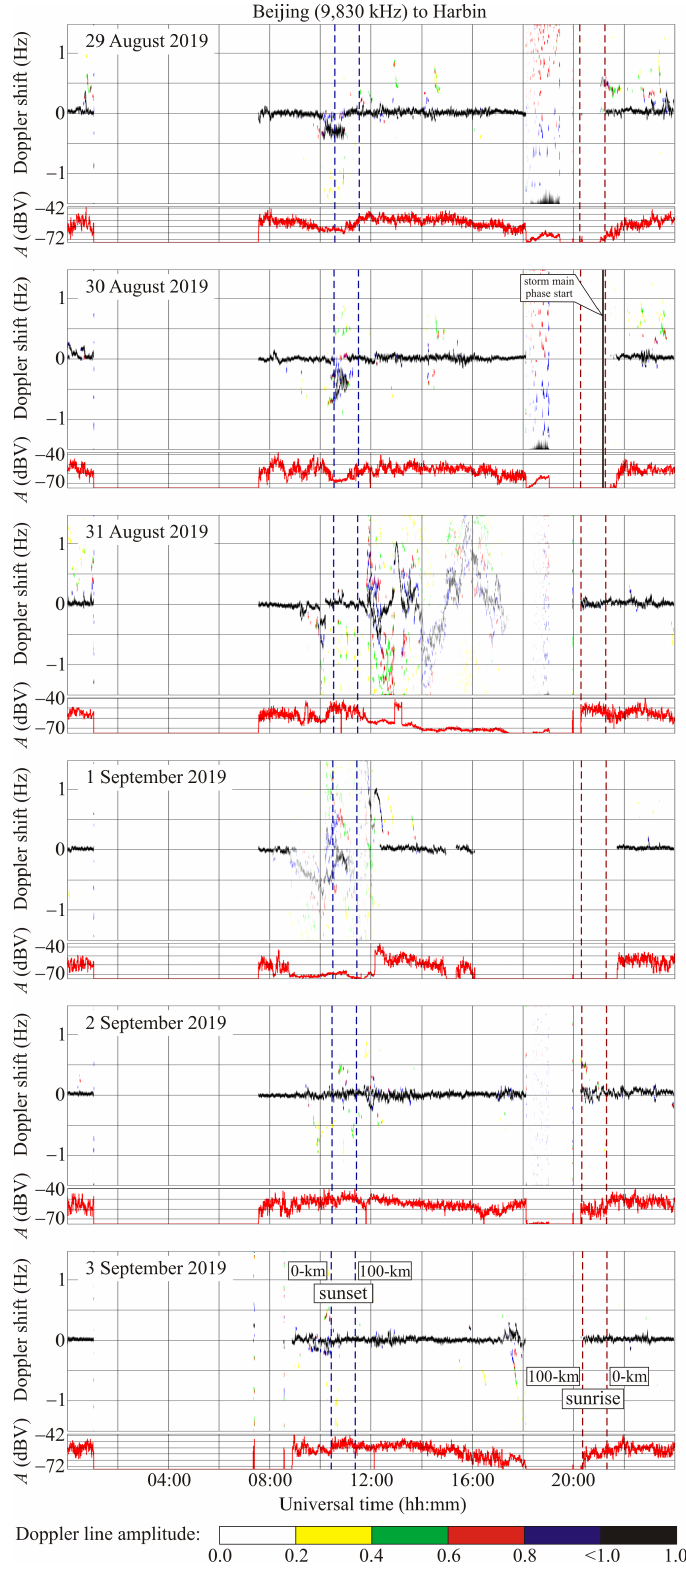
Figure 15. Same as Fig. 5 but for the Beijing to Harbin radio wave propagation path at